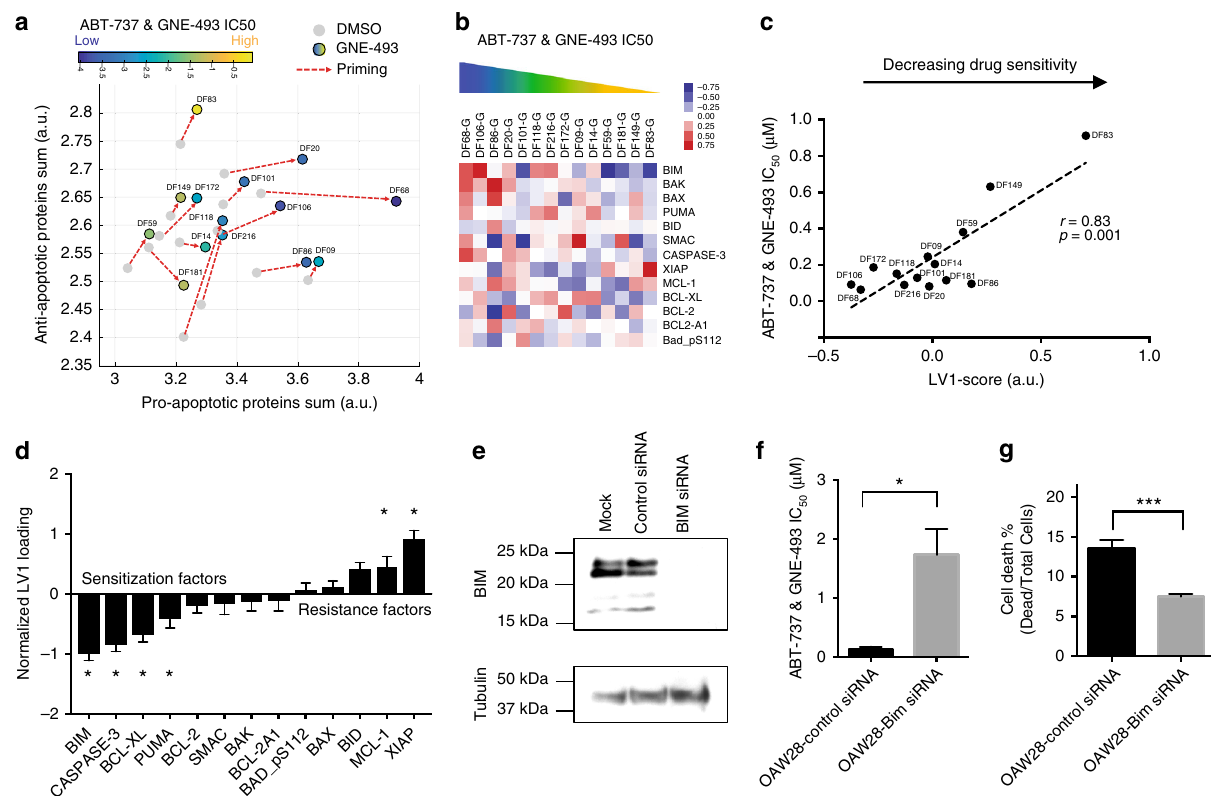
Fig. 5 Computational modeling identi fi es predictors of sensitivity and resistance to combined PI3K/mTOR and BCL-2/BCL-X L inhibition. a Relationship between apoptotic priming (vector-plot: shows change induced by GNE-493 treatment) and GNE-493 and ABT-737 sensitivity (IC 50 values) b Heatmap of apoptosis-regulating proteins (median-centered) after GNE-493 treatment (48 h, 0.5 μ M). c Partial least-squares regression (PLSR) analysis identi fi es a latent variable LV1 (LV1 score) that correlates with drug sensitivity. d Ranking of the contribution of each apoptosis-regulating protein in LV1. Mean ± SD for each protein from a leave-one-out cross validation analysis. Proteins with regression coef fi cients different than zero are marked with an asterisk. e BIM siRNA knockdown reduces BIM protein levels (96 h after knockdown) in OAW28. f Analysis of GNE-493 and ABT-737 IC 50 value after BIM siRNA knockdown in OAW28. g BIM siRNA knockdown rescues cell death (laser scanning cytometry measurements) induced by the GNE-493 and ABT-737 drug combination in OAW28. Errors are SEM for n = 4 replicate wells and results are representative of two independent experiments. (Two-tailed student t -test: * p < 0.05, *** p <